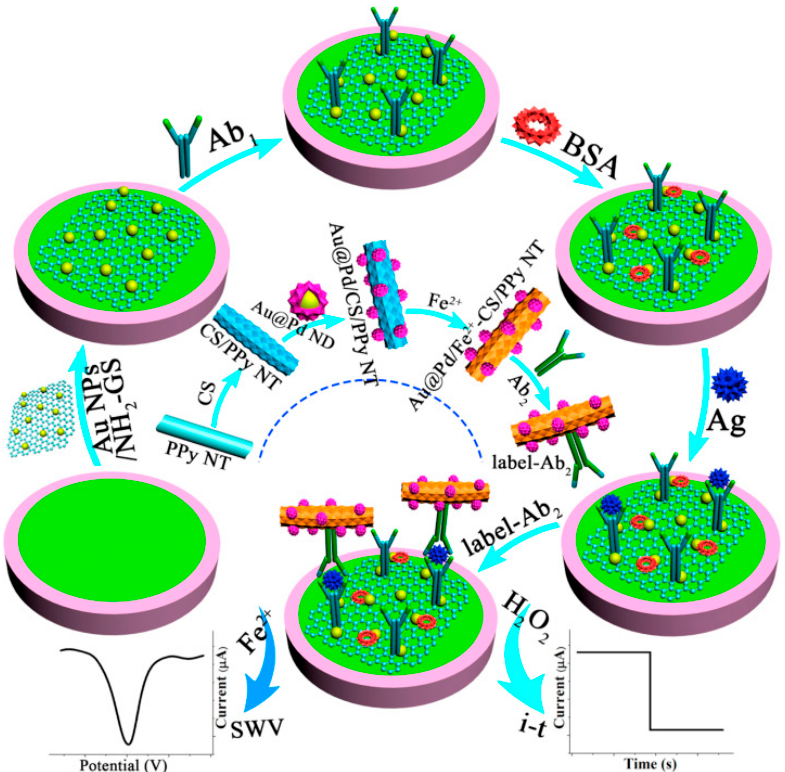
Figure 4. The preparation process of Au@Pd NDs/Fe 2+ -CS/PPy NTs and the schemata of the fabrication process of the working electrode for label-free immunosensors. Reprinted with permission from ref. [47]. Copyright 2018 Elsevier.